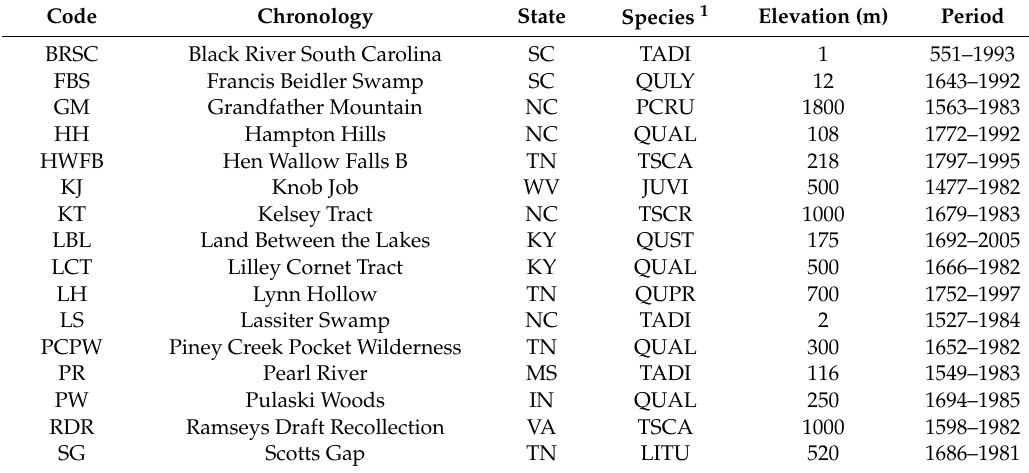
Table3. Tree-ringchronologiesretainedinthestepwiseregressionmodelsandusedforthereconstructions.